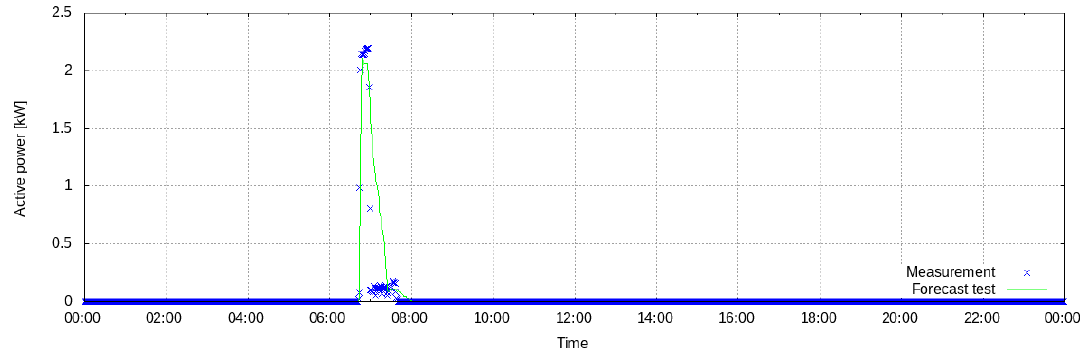
Figure 10. Ground truth and prediction of the power consumed by the washing machine within a 24-h forecast horizon (date: 11 July